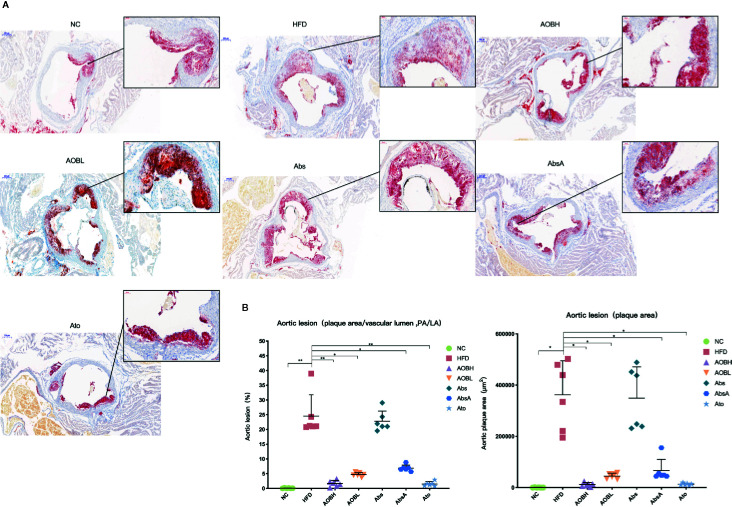
AOB impacts on atherosclerotic lesions. (A) Oil red O staining of plaques in the NC, HFD, AOBH, AOBL, Abs, Abs, and Ato aortic root cross-sections. (B) Quantitative examination of the percentage of plaque area compared to the vascular lumen area and plaque region; ANOVA calculated disparities. Compared to the HFD community, *p < 0.05, **p < 0.01.